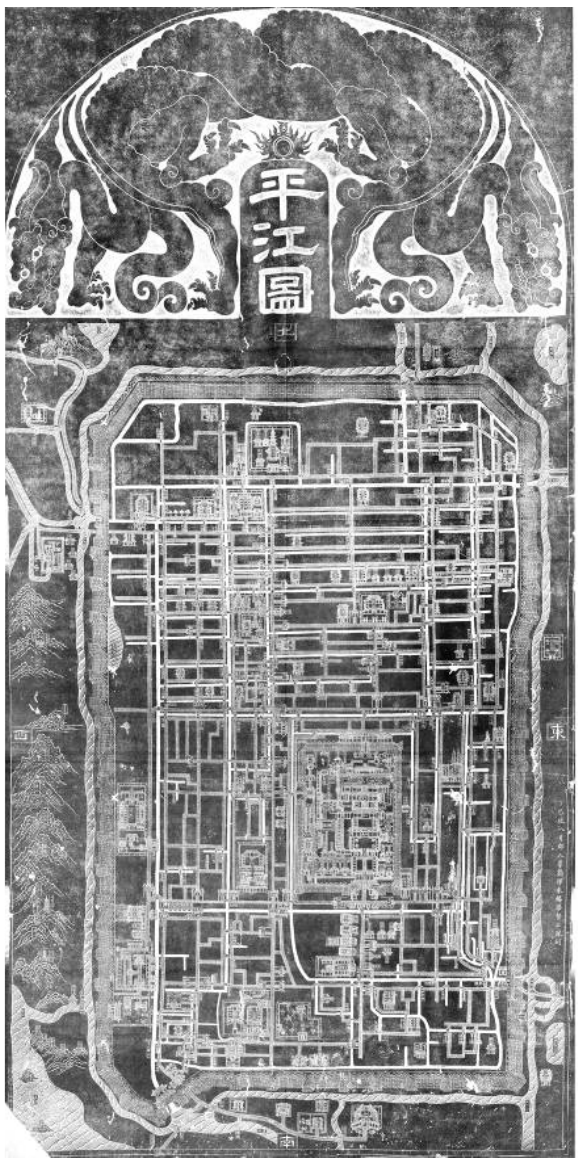
Figure 2. The Map of Pingjiang engraved in 1229.